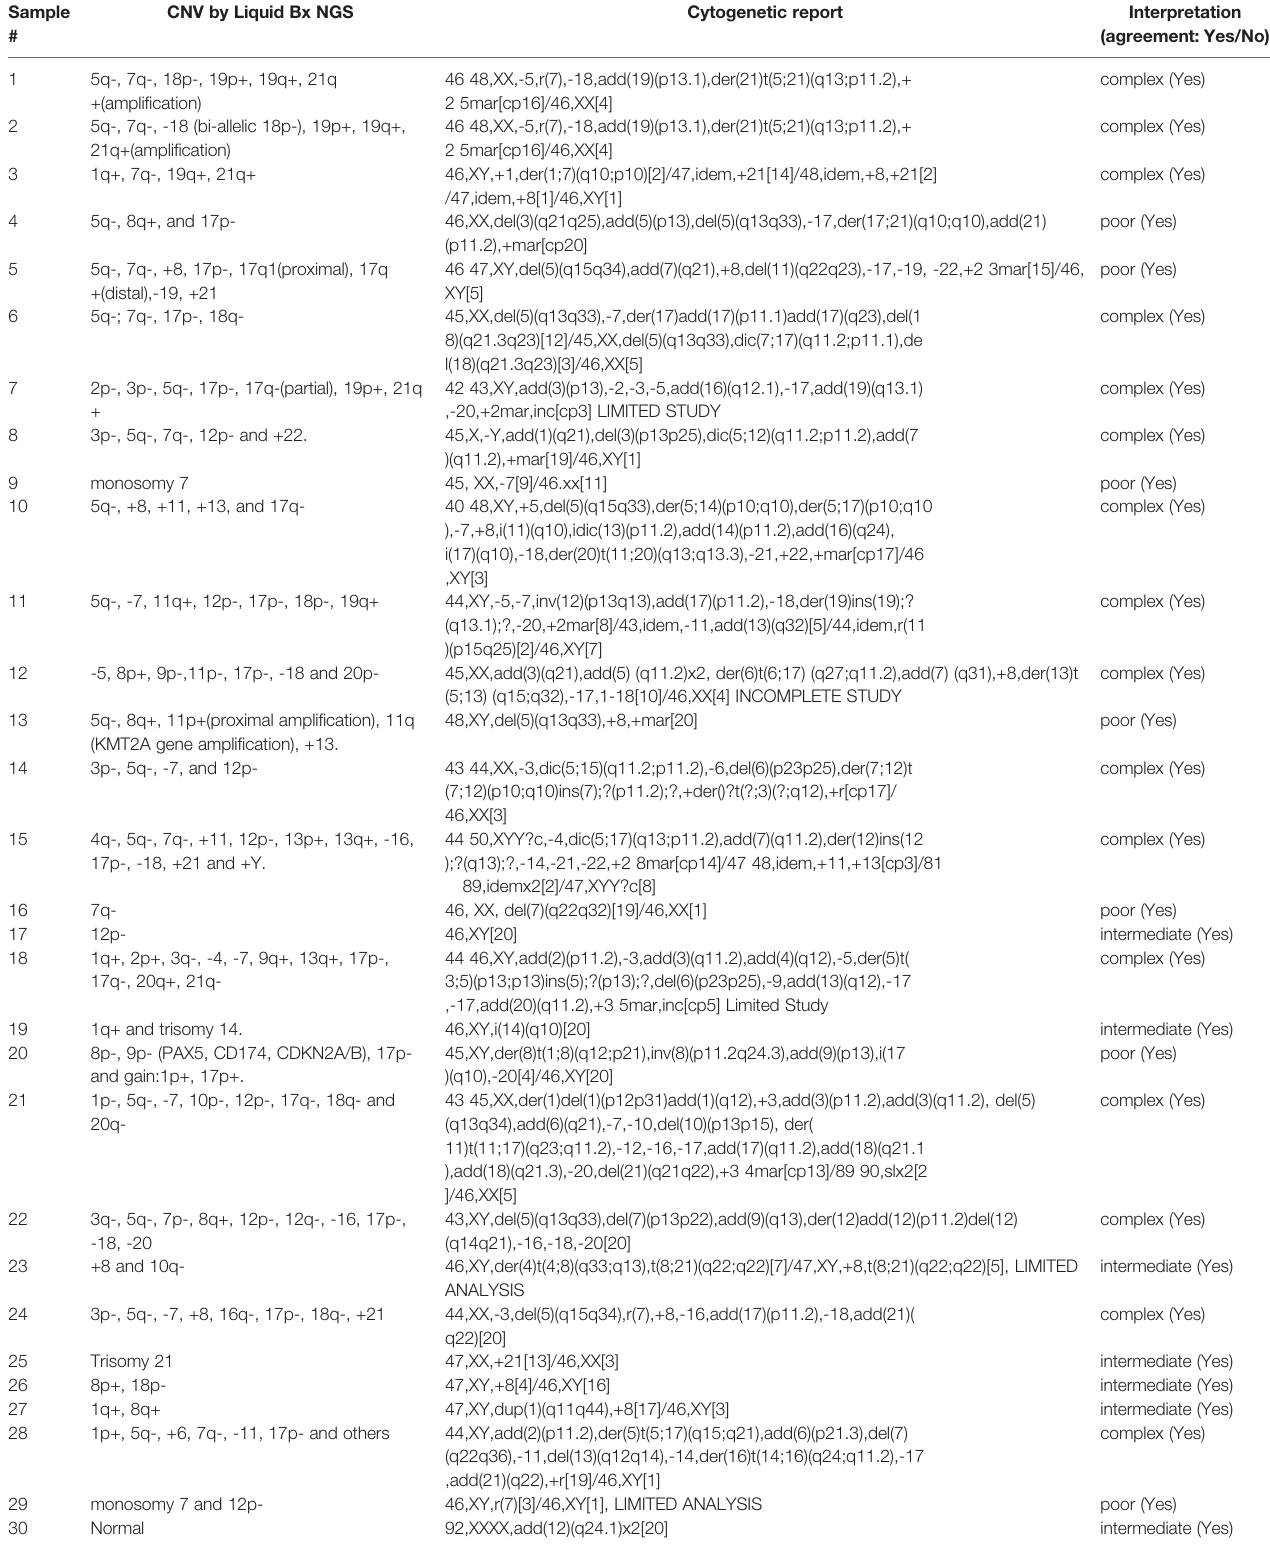
TABLE 2 | Targeted NGS vs. Conventional karyotypic/cytogenetic testing in predicting myelodysplastic or acute myeloid leukemia risk strati fi cation* in individual patient samples. Sample